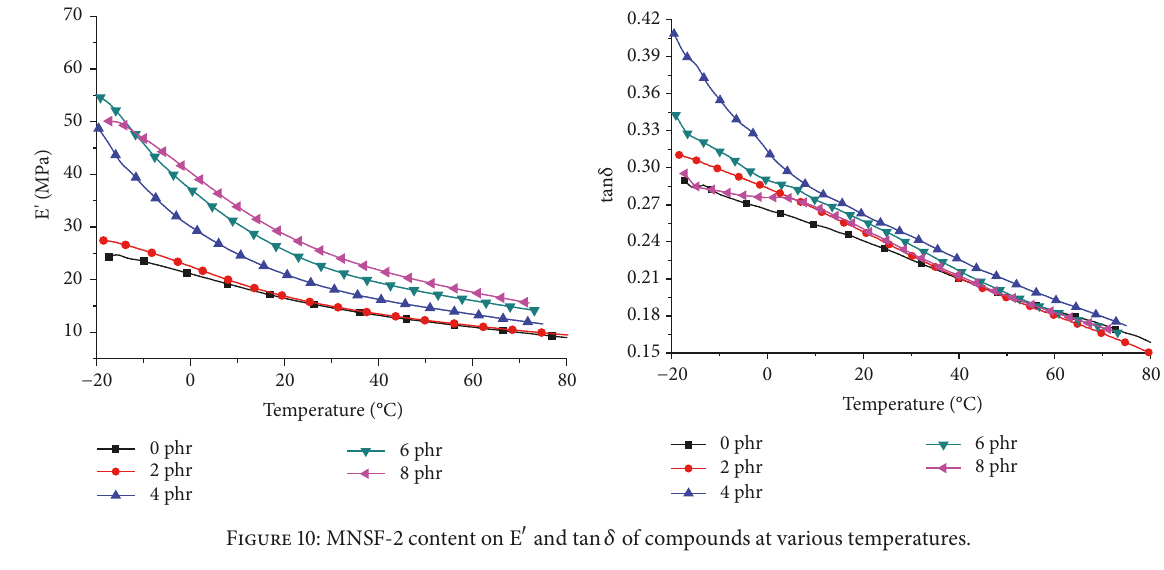
Figure 10: MNSF-2 content on E 󸀠 and tan 𝛿 of compounds at various temperatures.